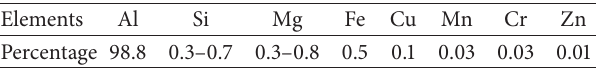
Table1:Nominalchemicalcompositionofthealuminumalloy6101-